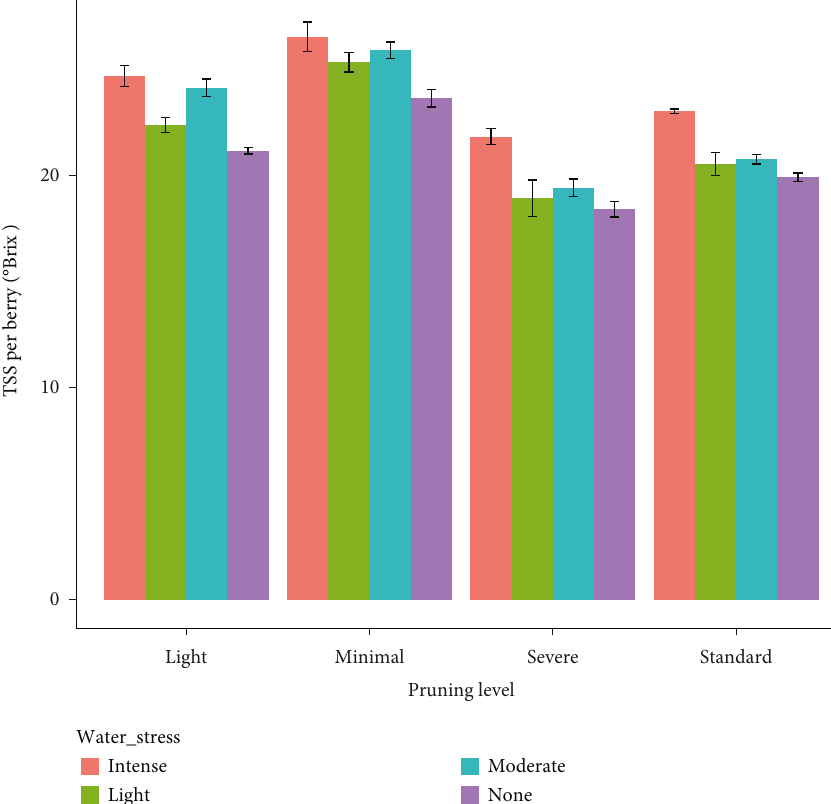
Figure 8: Response of TSS to combination effect of pruning level and post-veraison water stress.